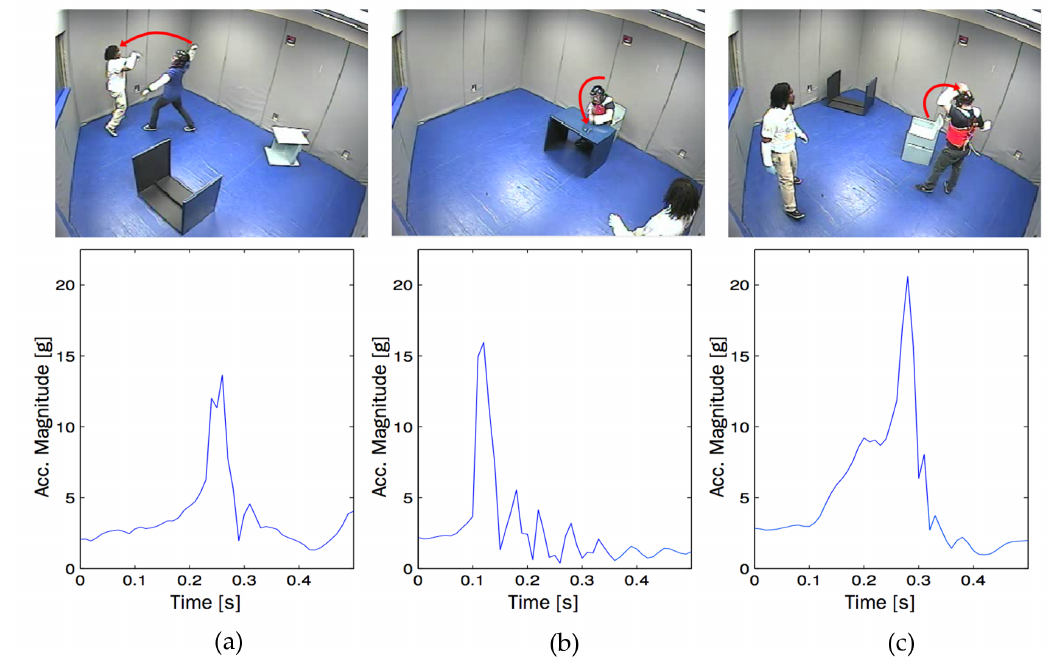
Figure 4. Video snapshot and acceleration readings for ( a ) aggression; ( b ) disruption; ( c ) self-injury. ( c (cid:13) 2012 ACM. Reprinted with permission